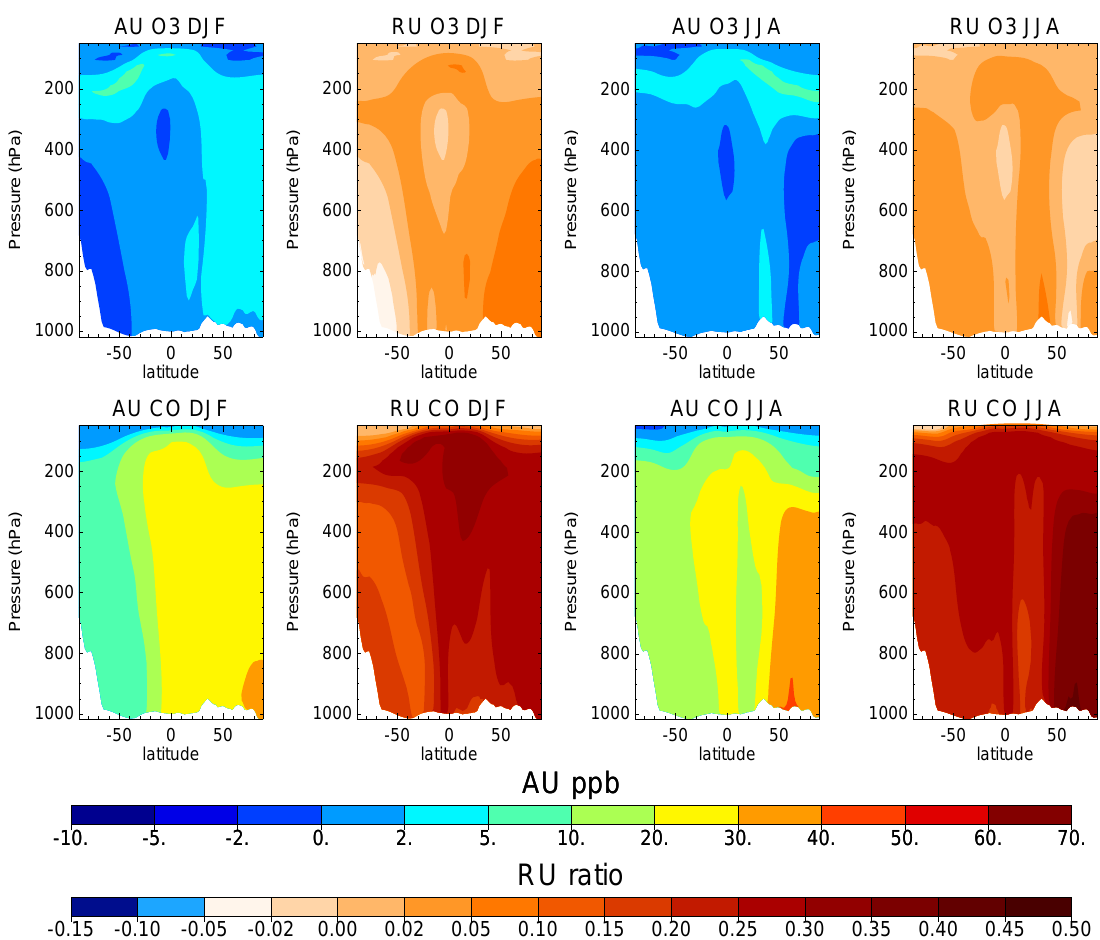
Fig. 12. The AU and RU introduced by the variability in biogenic emission estimates towards the Seasonal Zonal means for tropospheric O 3 (top) and CO (bottom). Values are shown for seasons DJF and